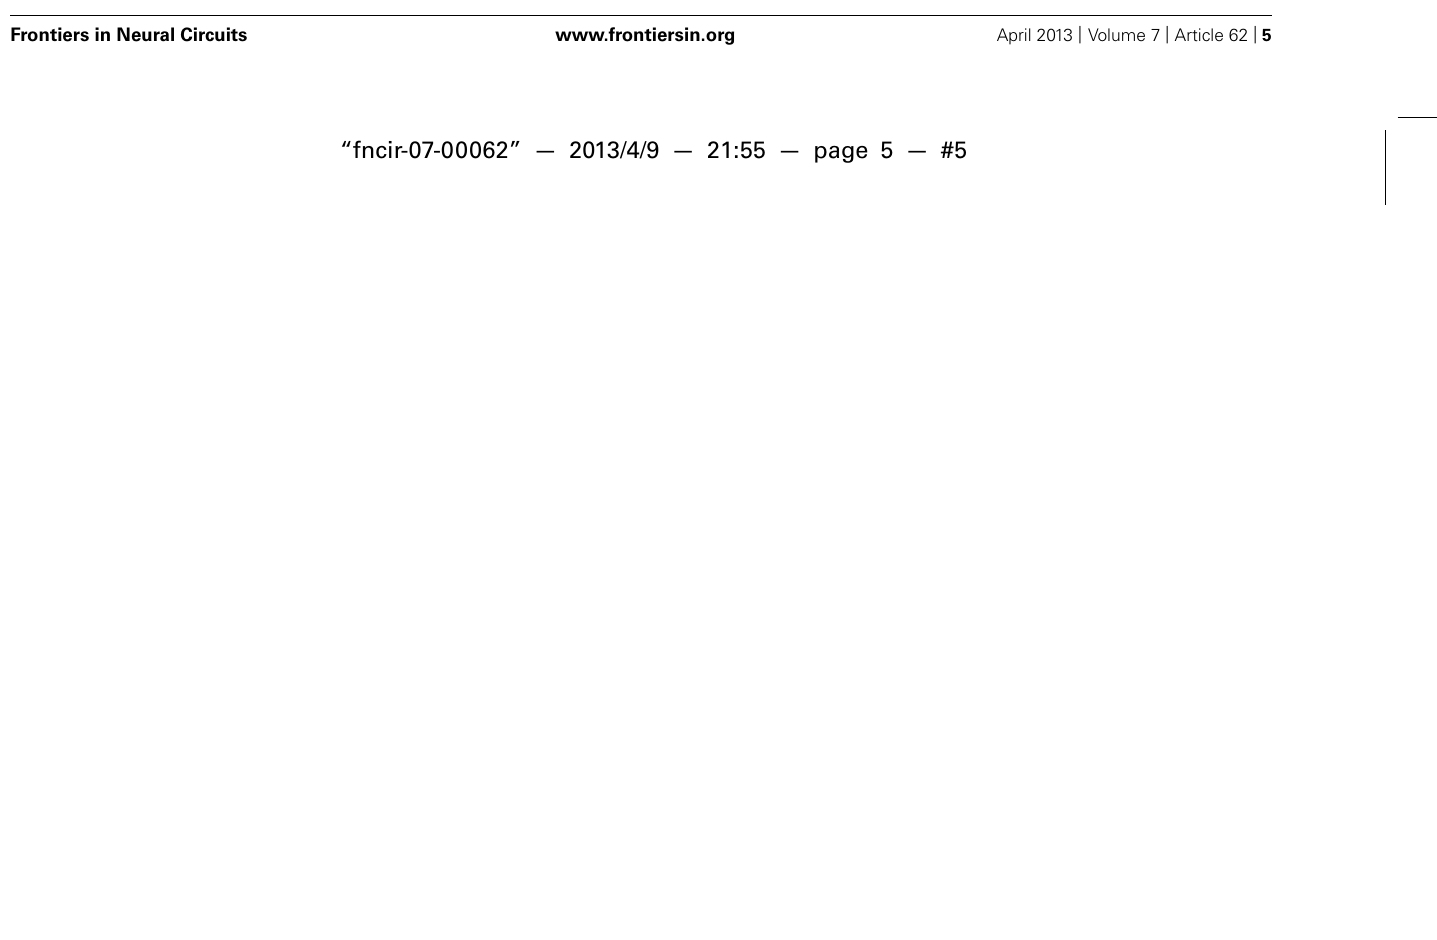
zebrafish. Dotted lines represent connections described in other fish species. OE: olfactory epithelium, OB: olfactory bulb,TE: telencephalon, Dp: dorsal-posterior part of the telencephalon, Hb: habenula,Vv: ventral nucleus of the ventral telencephalon, OT: optic tectum, PT: posterior tubercle, HT: hypothalamus, CB: cerebellum, MLR: mesencephalic locomotor region; RST: reticulo-spinal tract, SC: spinal